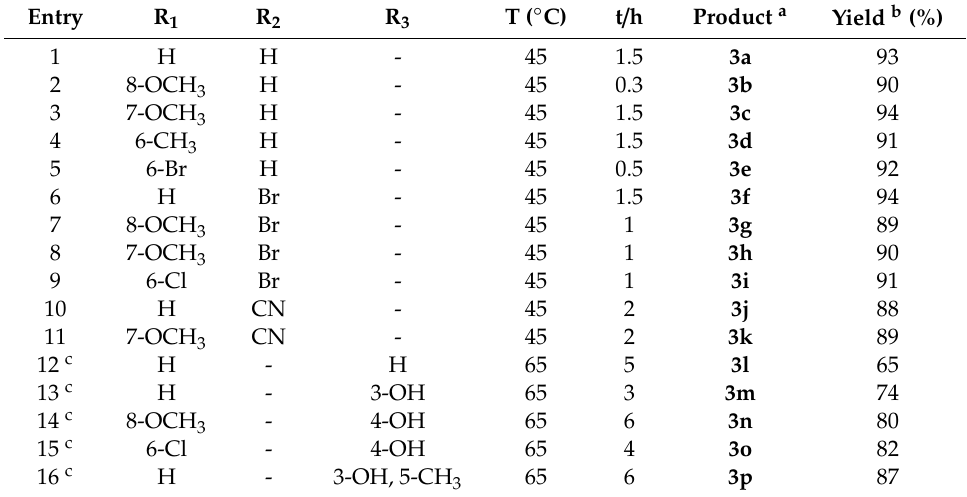
Table 2. Synthesis of compounds 3a – p .